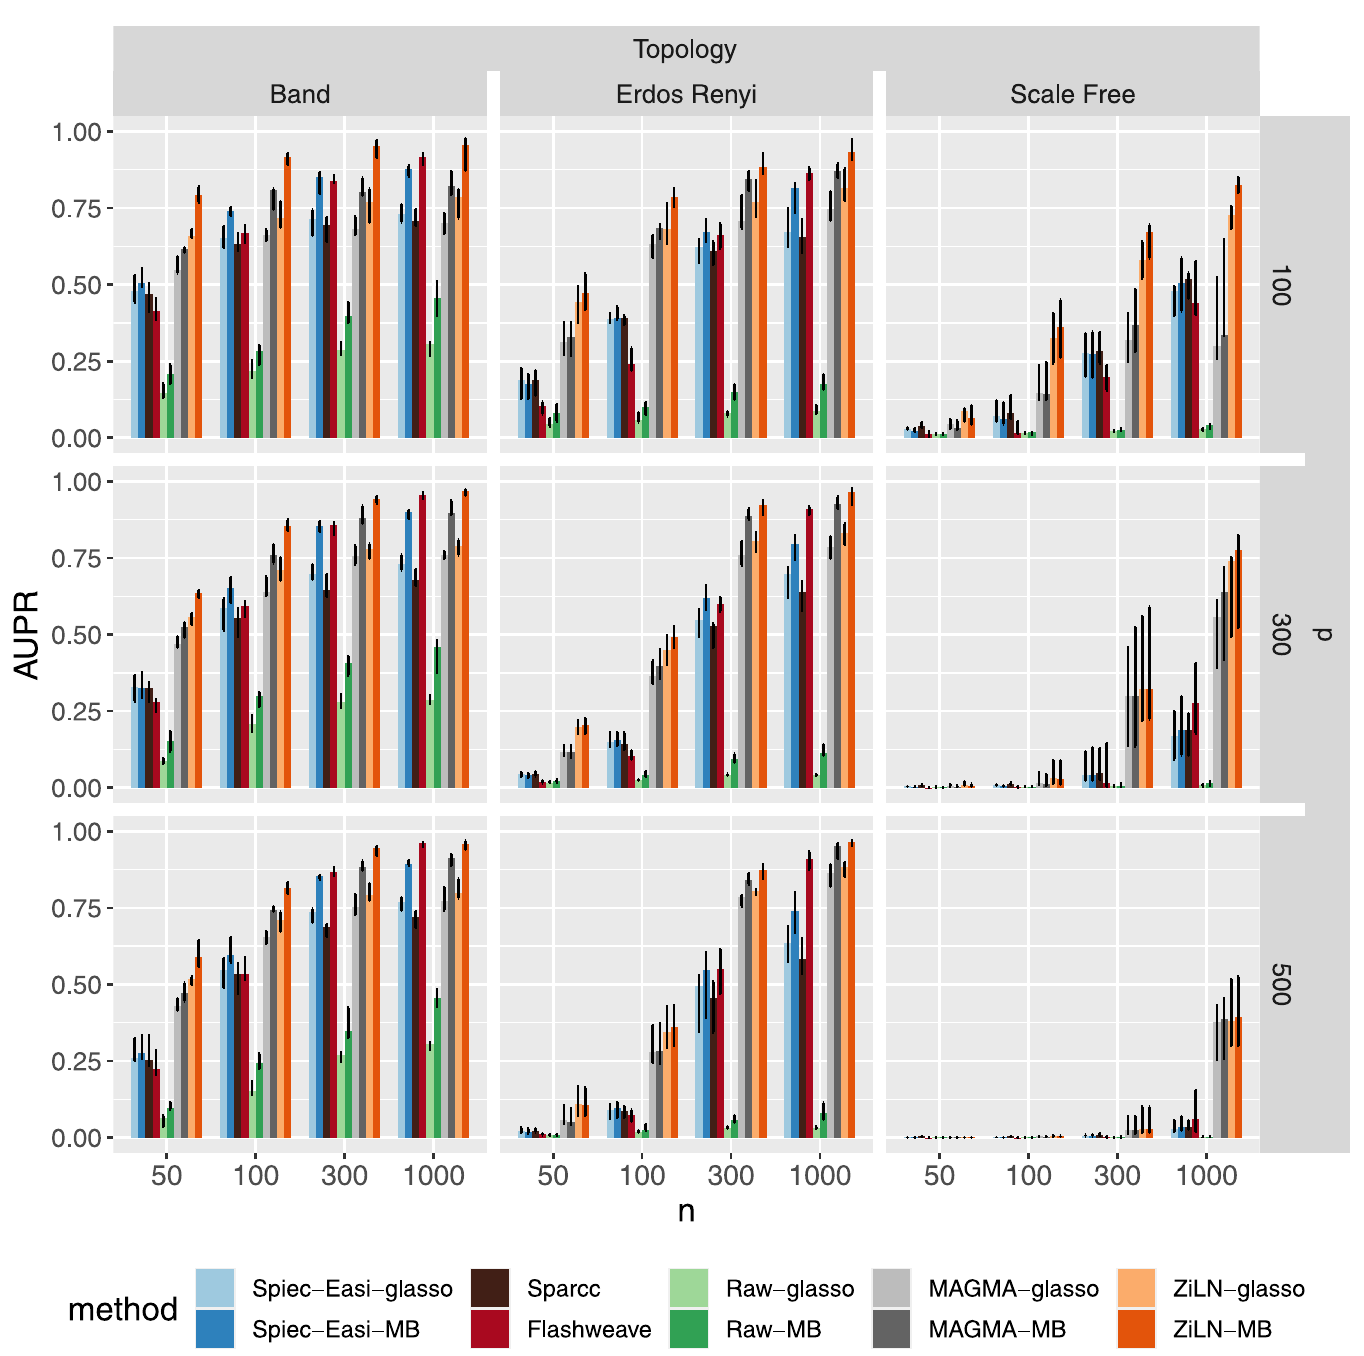
Fig 2. Effect of the number of samples ( n ), number of taxa ( p ) and network topology on the performance of the various methods, measured with the area under precision-recall curve (AUPR), on synthetic datasets. Bars represent the median over 10 runs, and error bars + 25% and − 25% quantiles. Each method (Spiec-Easi (blue) [23], MAGMA (gray) [24] and ours (ZiLN, orange), as well as no transformation at all (green)), was tested with two structure inference algorithms (glasso and neighborhood selection). Two other orthogonal (i.e. based on distinct rationales) network inference methods, sparcc (dark-brown) [36] and Flashweave (dark-red) [37], were included to broaden the